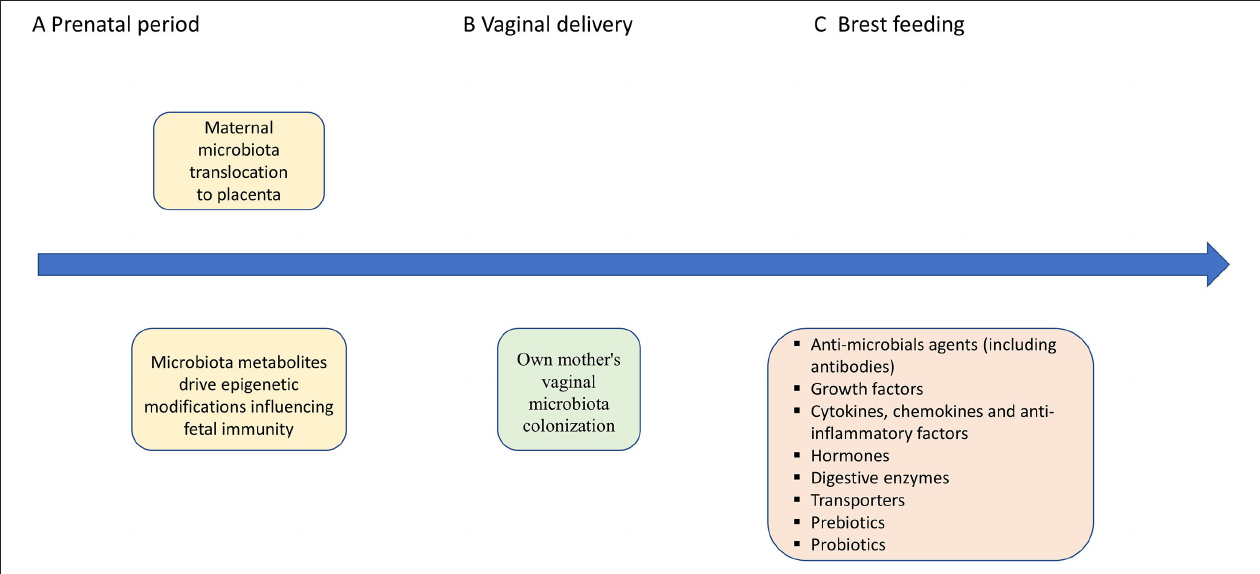
FIGURE 2 | Potential mechanisms of maternal microbiota, vaginal delivery, breast feeding effects on the fetal/infant immunity. (A) The early microbial colonization in humans is necessary to maintain a balance between maternal and fetal immunity ( 30). Fetal microbiota, or their molecular signatures, may form mucosal immunity and prepare the tissues for colonization following birth ( 18). The maternal microbes and their metabolites have impact on immunity development by epigenetic modifications influencing Th1/Th2 balance, production of SCFAs that may induce T-cell activation and modulate IL-10 release, as well as regulation of TLRs ( 5, 33–35). (B,C) Vaginal delivery assures own mother’s vaginal microbiota colonization. Breast feeding with all bioactive factors assures protective role against infections and maintains the mucosal epithelium and the development of the microbiome (36). Moreover, mother-derived active molecules (including immunoglobulins) assure gut homeostasis with regard to the newly colonizing microbiota by regulating the immune system in the GALT and shaping Innate Lymphoid Cell development in the intestine (36). Milk-derived antibodies from the mother’s milk support the child with a passive immunity during the infancy (37). Short-chain fatty acids (SCFAs),